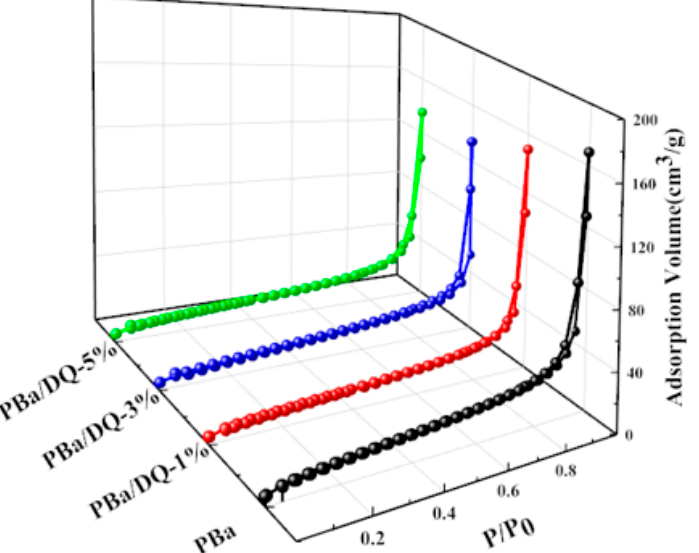
Figure 4. Nitrogen adsorption-desorption isotherms of aerogels.